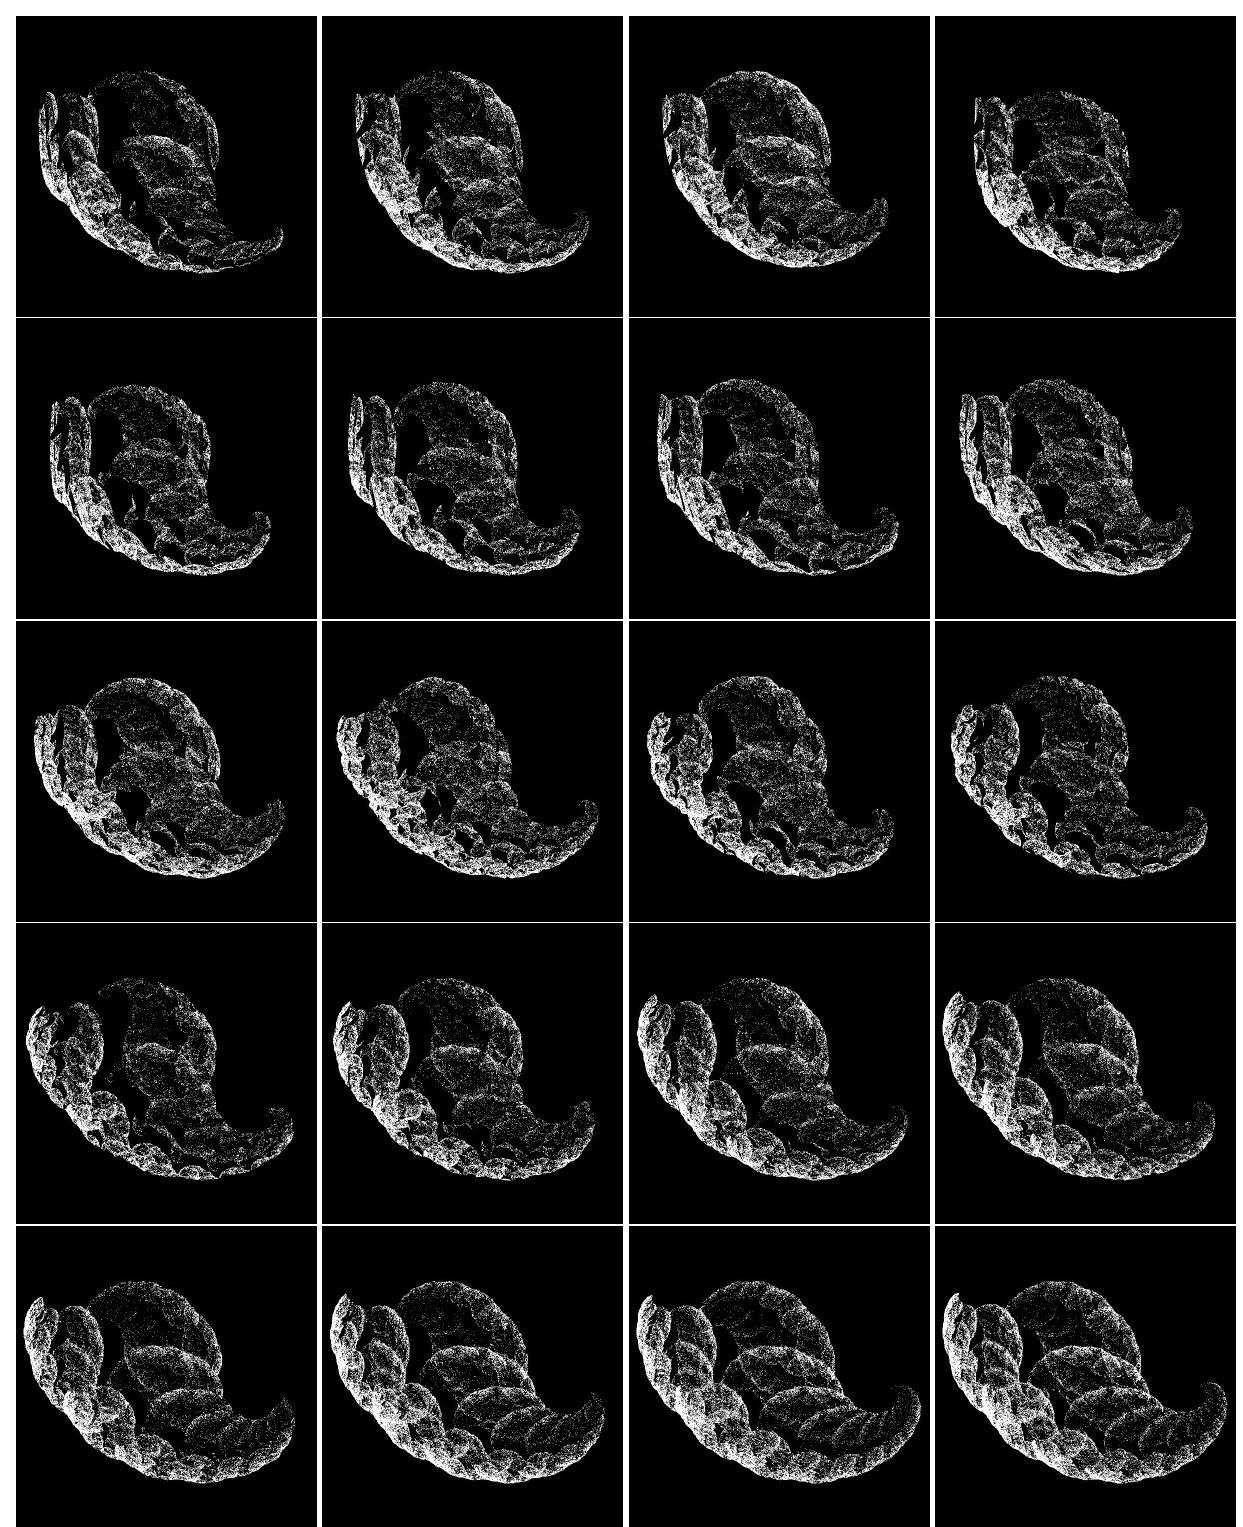
Figure 9. ( left – right , top – bottom ): Evolution of the intersection between the original and the recon- structed images for 800–1180 iterations (step size, 20